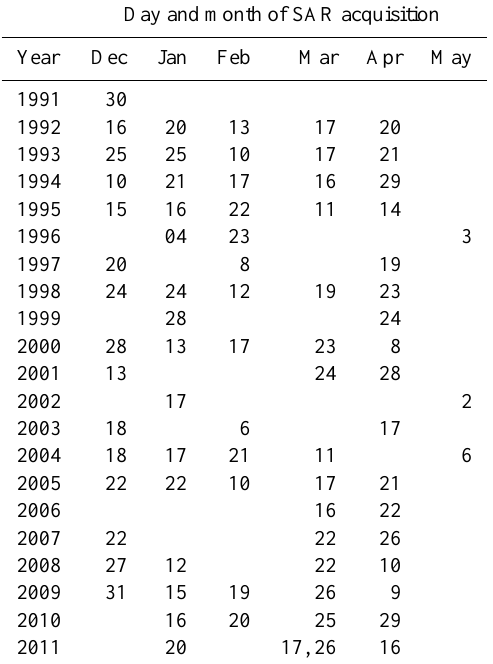
Table 1. Dates of ERS-1 / 2 acquisitions used for image segmen- tation in order to determine the monthly fraction of grounded ice (1991–2011). Day and month of SAR acquisition